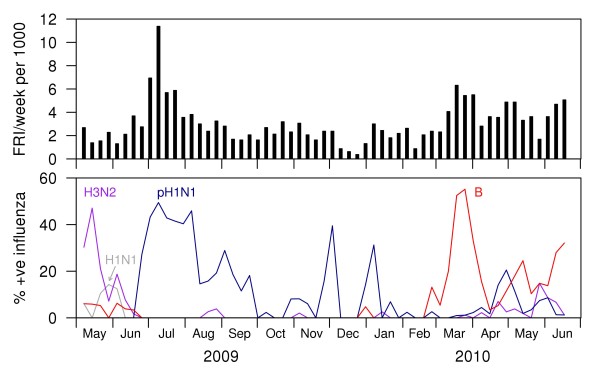
Distribution of influenza cases during study period. The top panel presents the weekly number of febrile respiratory infections per 1000 population. The bottom panel presents the proportion positive for each influenza subtype.